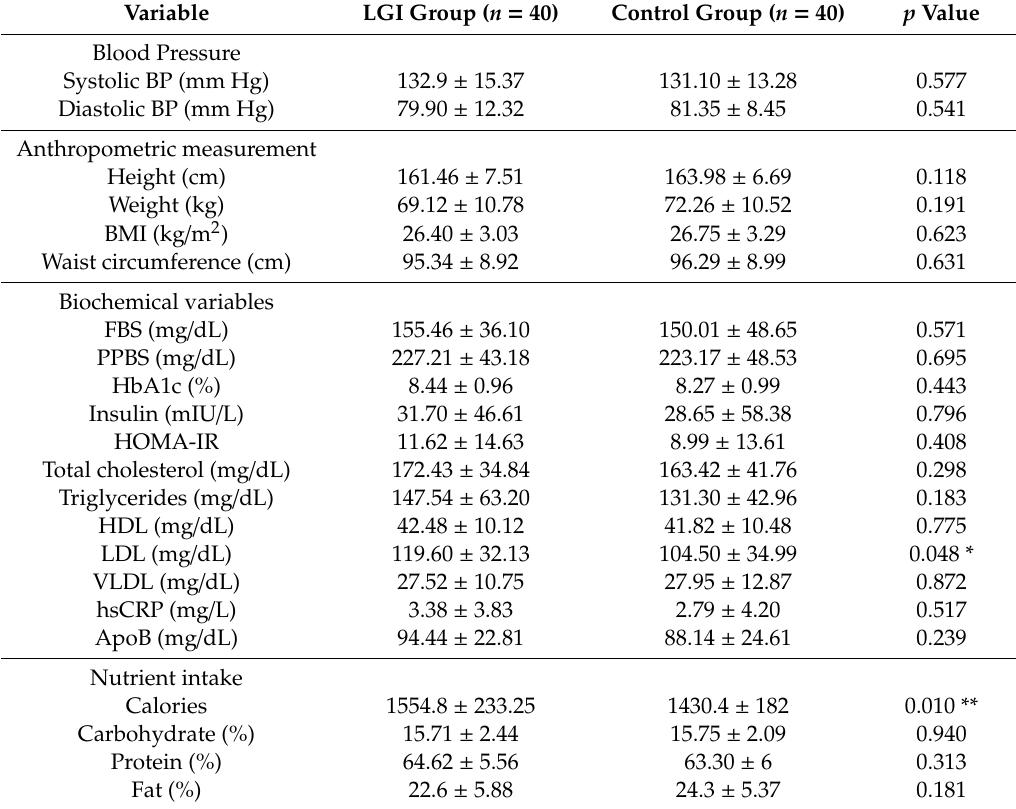
Table 3. Comparison of the baseline characteristics of the study